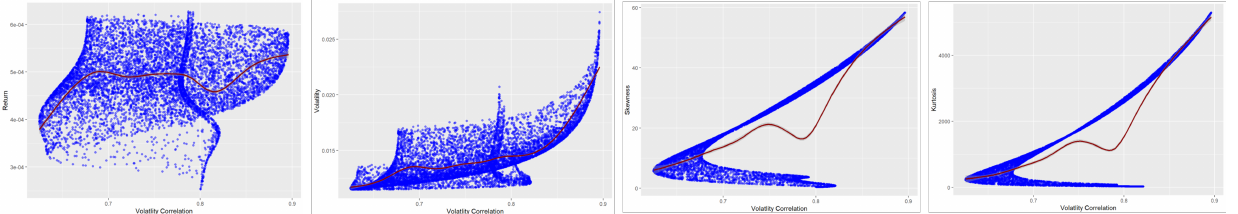
Figure 9. Relationship between mean, volatility, skewness, kurtosis, and volatility correlation of Cryptocurrencies (Group 2).